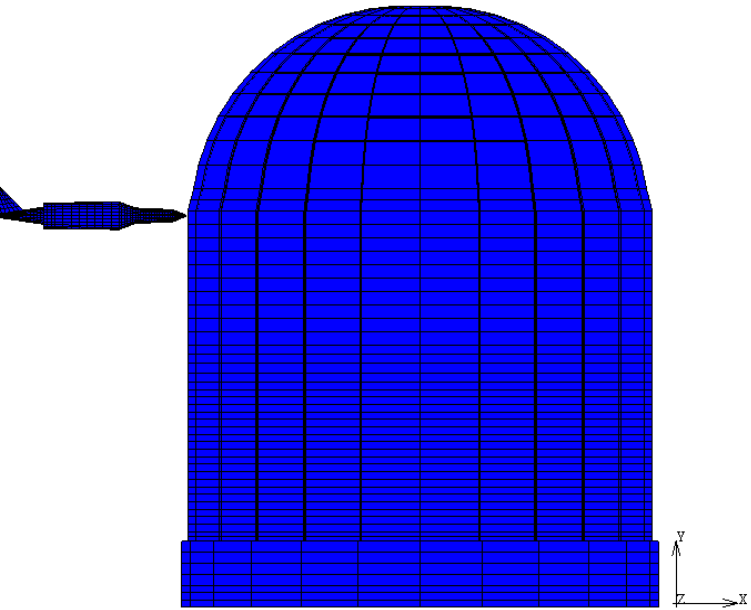
Figure 8. Horizontal aircraft impact configuration. Models represent the explicit interaction of the missile and target by means of a gap contact.